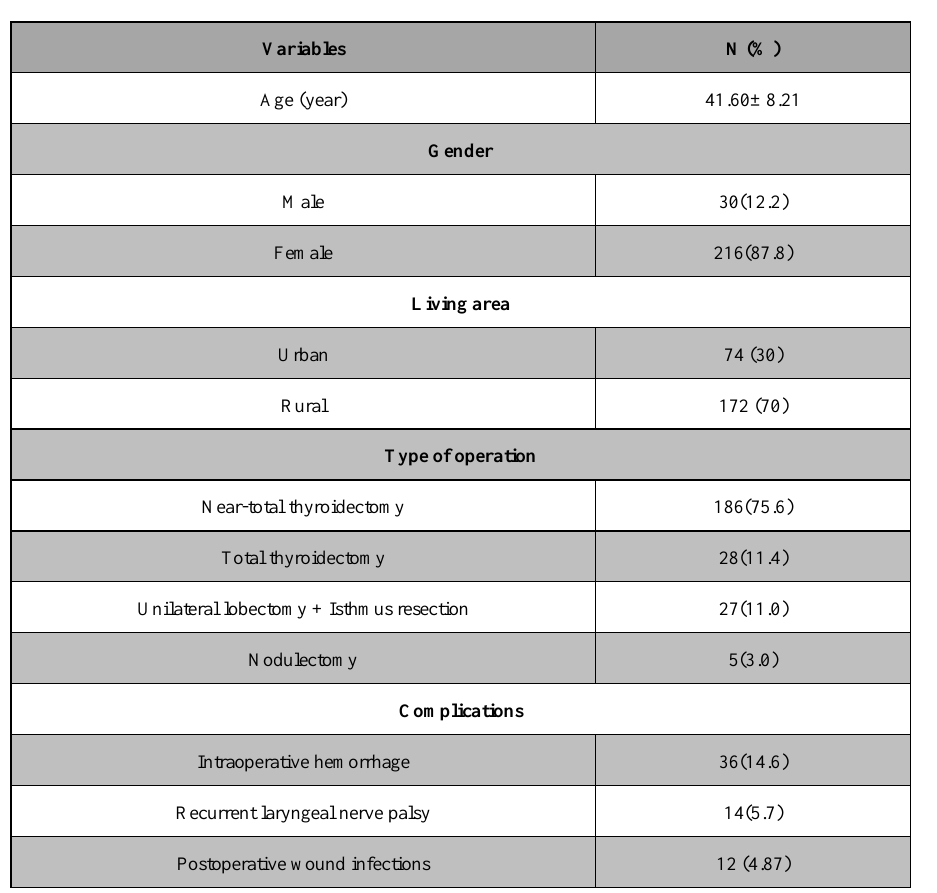
Table 1. The patients'